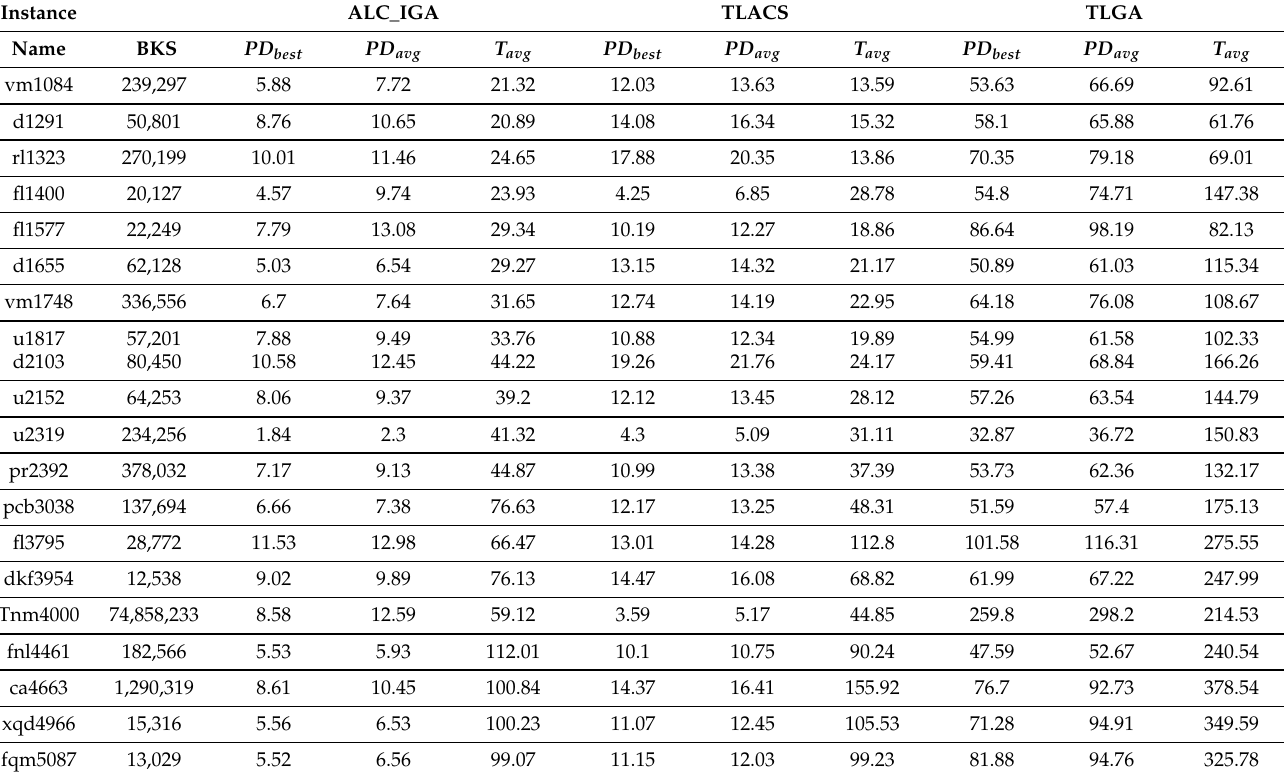
Table 6. Results obtained by ALC_IGA, TLACS, and TLGA with single thread on medium-scale